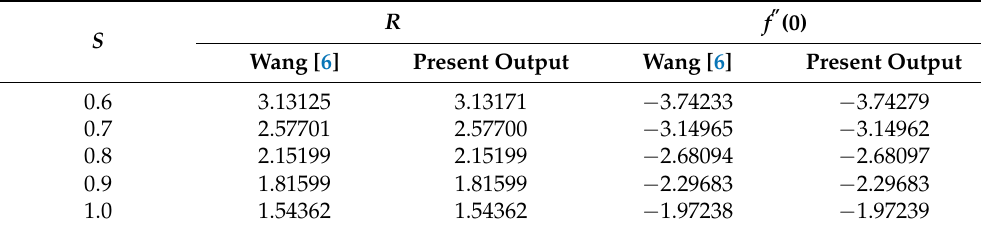
Table 3. By comparing the numerical values of f (cid:48)(cid:48) ( 0 ) when m and Pr are equal to one and We x , M , and S are equal to zero with those found in previous related studies, a better understanding can be gained. R f ” (0) S Wang [6] Present Output Wang [6] Present Output